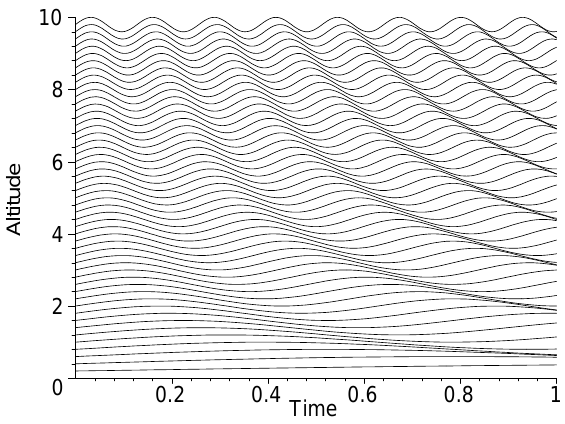
Fig. 1. Phase changes with time and space for a frequency that increases with altitude. All altitudes are assumed to be in phase initially.